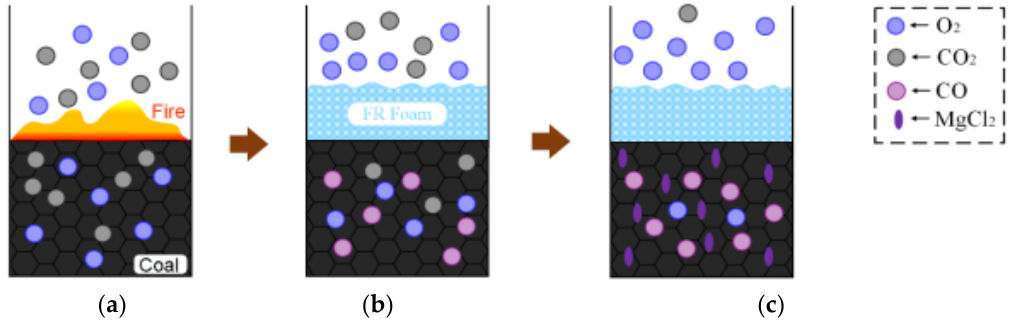
Figure 9. Schematic structure to prevent coal burning with fire-fighting foam [58]: ( a ) – Coal-air contact over a whole surface (C + O 2 = CO 2 ); ( b ) – insulation of coal from oxygen (2C + O 2 = 2CO) (when coal is coated with fire-resistant foam); ( c ) – MgCl 2 solution penetrates into coal.